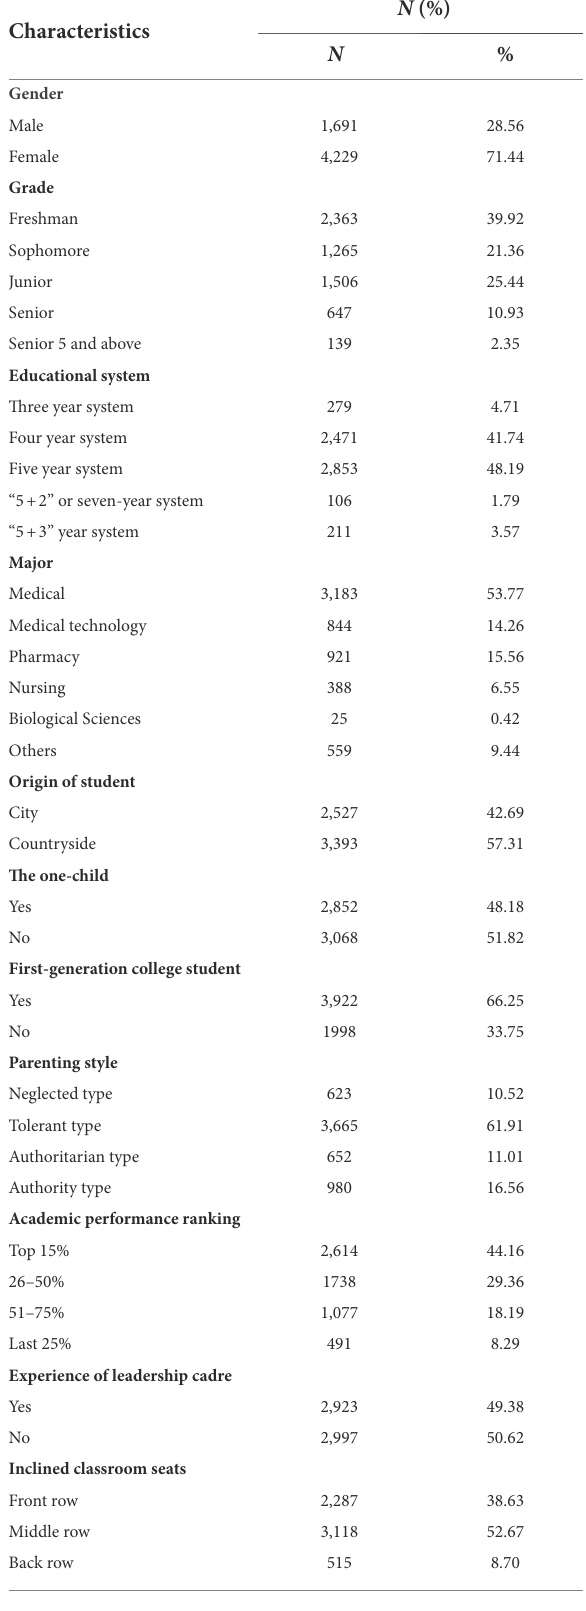
TABLE 2 Correlation coefficients among continuous variables of medical students ( N =